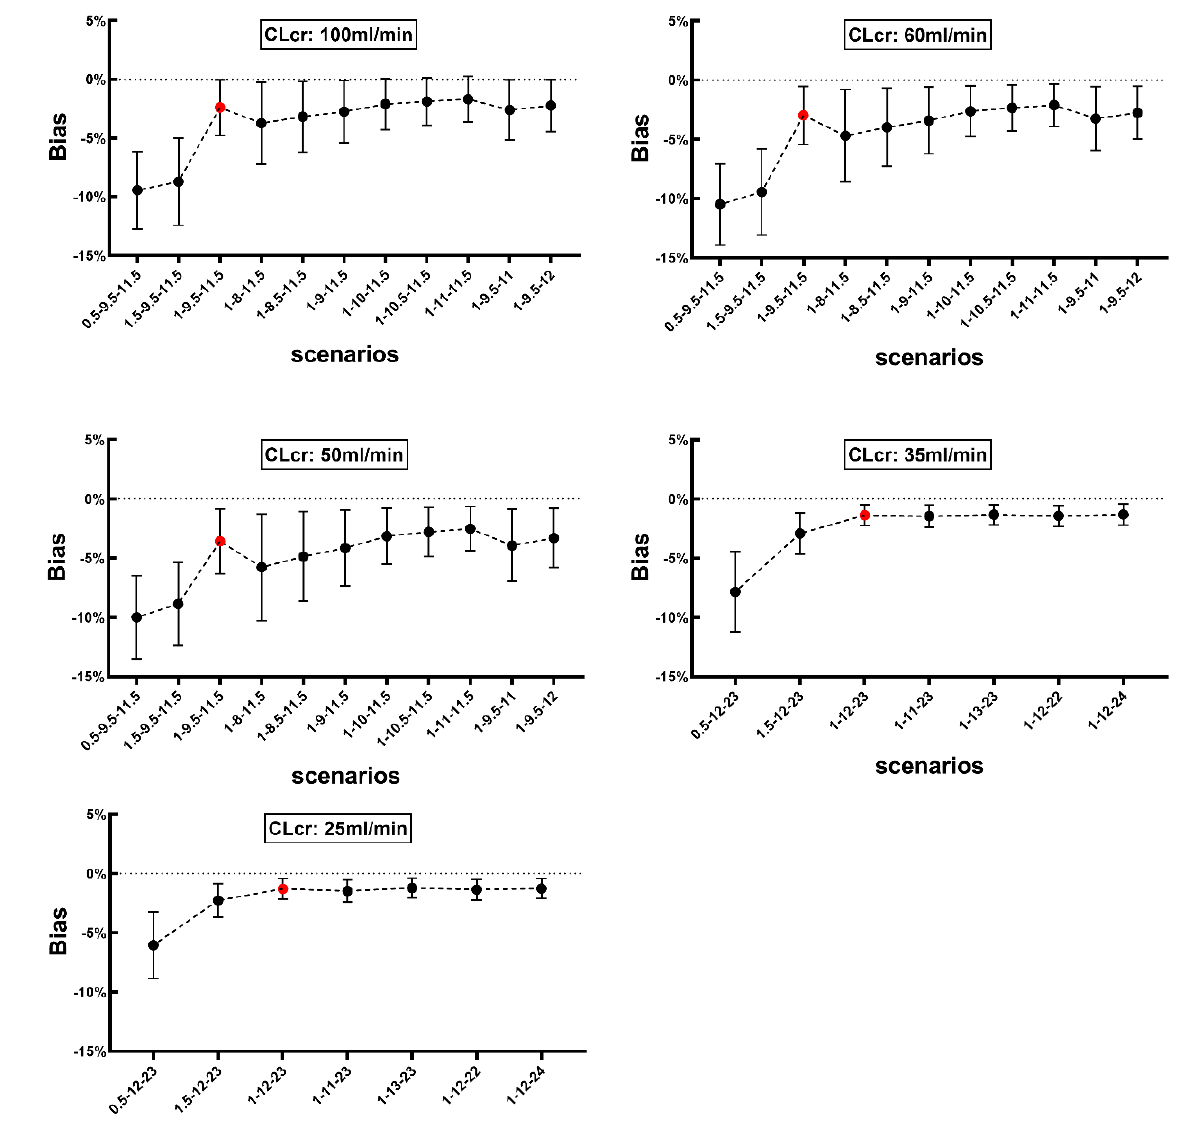
Figure 5. The effect of changing sampling time on bias for AUC 0– ∞ calculated using Method 2 in patients with various degrees of renal function (CLcr value: 100, 60, 50, 35, 25 mL/min). Red solid circle represents the mean bias when the three sampling time points set as per schedule, namely 1, 9.5 and 11.5 h after start of vancomycin intravenous infusion. Black solid circle represents the mean bias with changing one scheduled sampling time with the others being unchanged. X axis represents the sampling time schedule. Data is presented as mean and SD.